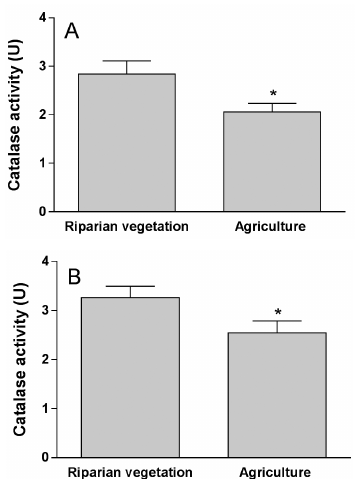
Figure 2. Catalase activity in Smicridea . (A) Cravo River sub-basin, (B) Campo River sub-basin. The data are presented as mean (± SEM). One unit of catalase activ- ity (U) corresponds to the enzyme necessary to degrade H O (μMol min –1 mg –1 protein). *Indicate p < 0.05, as 2 2 analyzed by student t test. Table 1. Concentrations of some metals in the water of Cravo and Campo sub-basins. Cravo river sub-basin Campo river sub-basin Riparian Agriculture vegetation vegetation